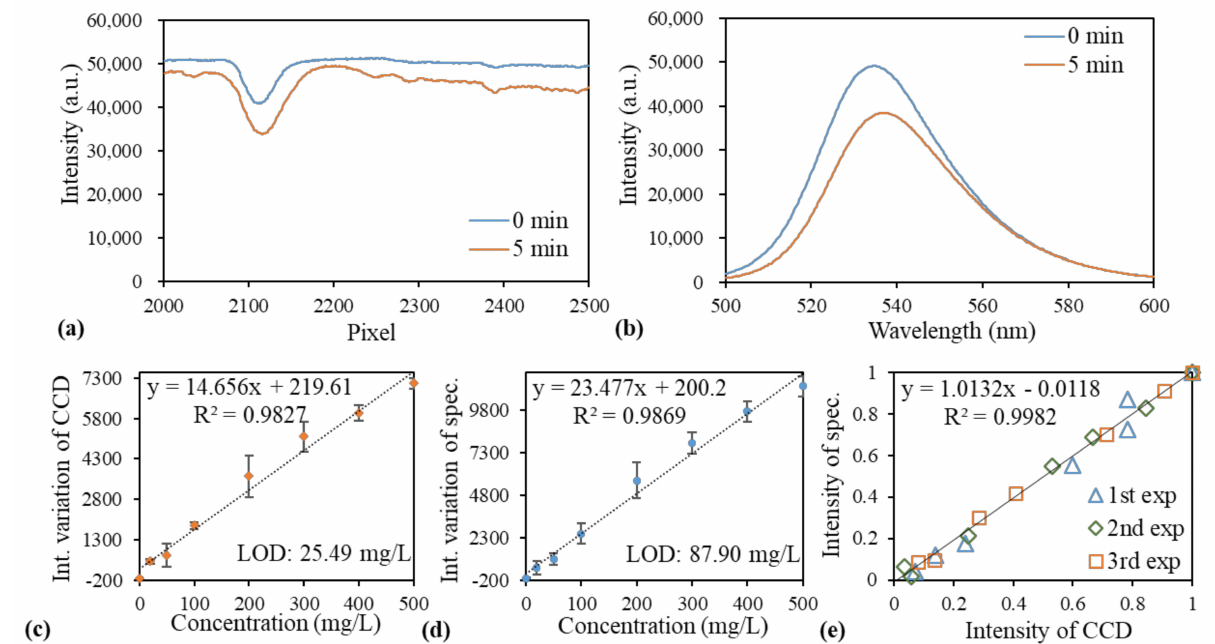
Figure 7. Intensity measured by the ( a ) GGP-GMR/CCD system and ( b ) spectrometer between 0 and 5 min at a creatinine concentration of 500 mg/L. The dose response curves of the normalized intensity difference between 0 and 5 min as a function of concentration measured with the ( c ) GGP-GMR/CCD device and ( d ) spectrometer. ( e ) Correlation between the two measurement